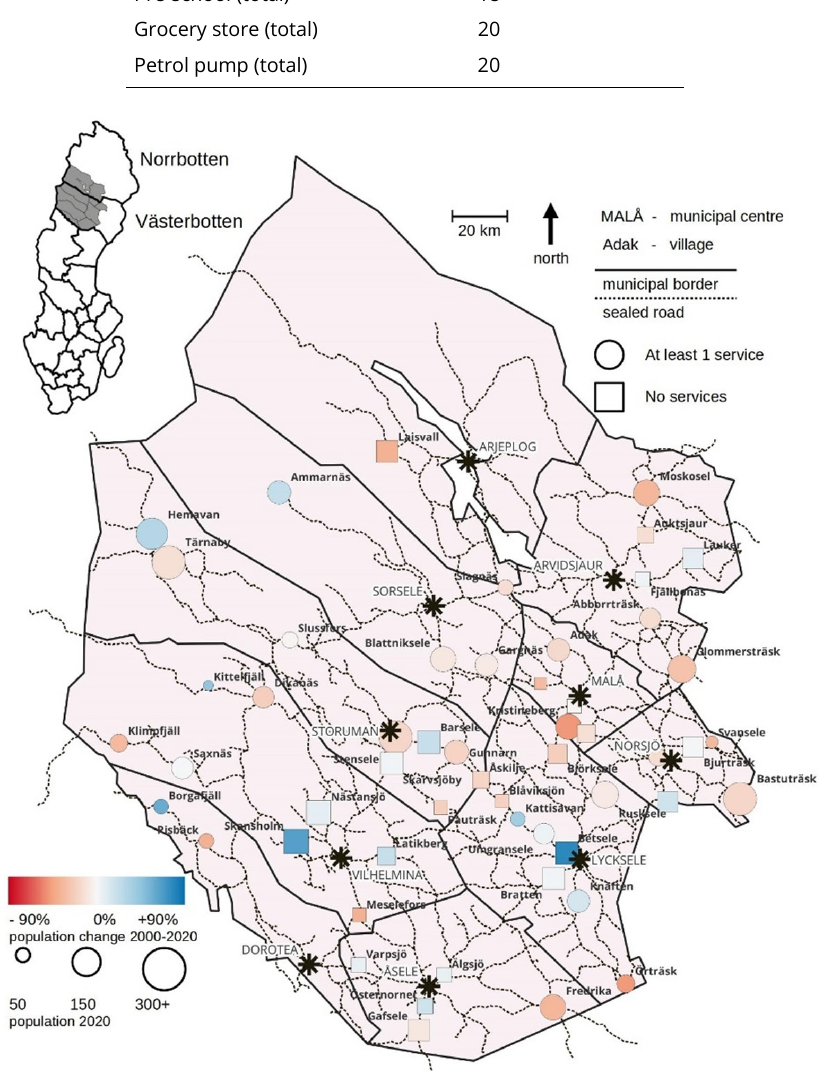
Fig 1. Distribution of villages with some (circle) and no (square) key